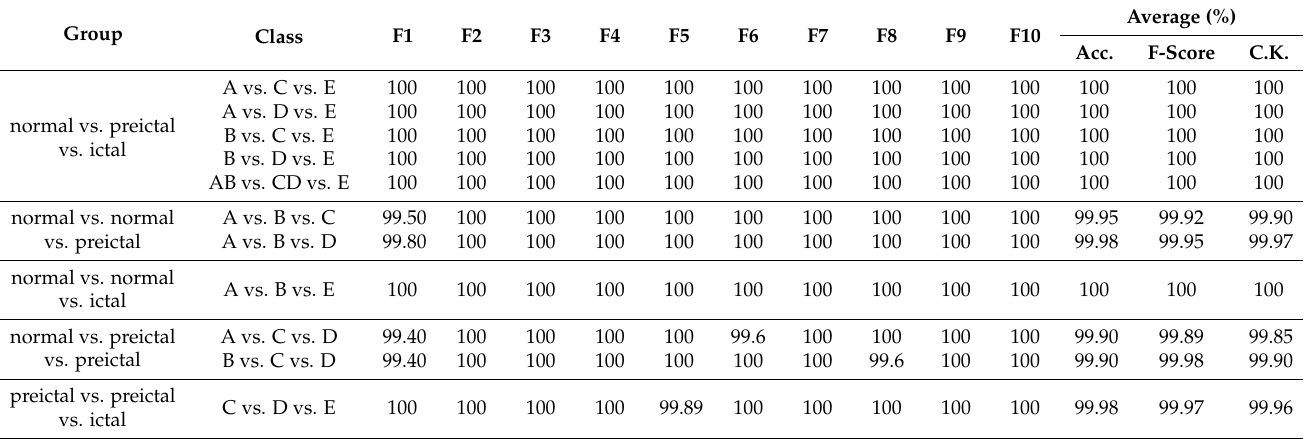
Table 3. Performance result of three class with 10-fold CV, here Fi means ith fold and all results are in